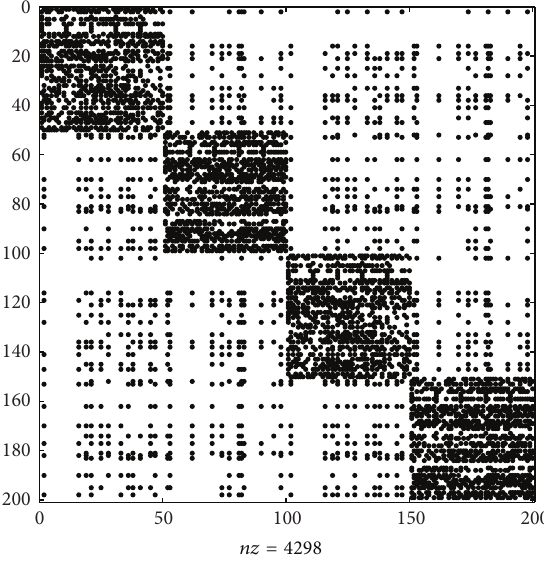
Figure 2: One of the three web link graphs, where the proportion between general nodes and common nodes is 7 :3 in each